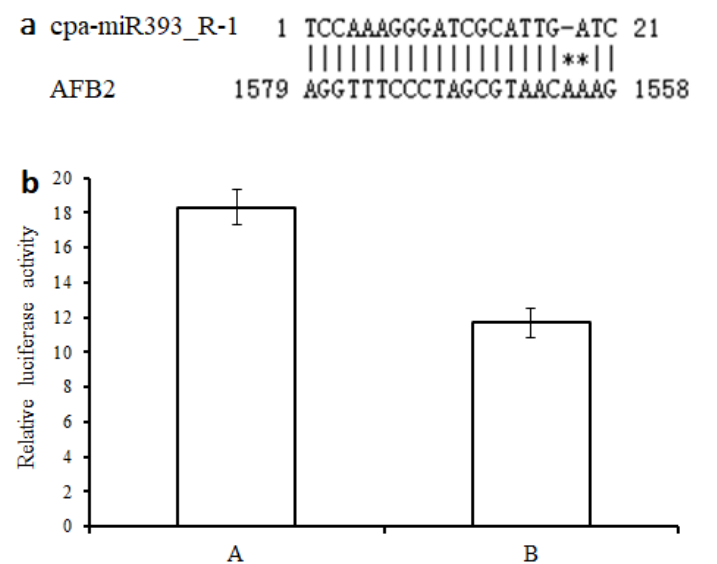
Figure 13. The validation of cpa-miR393_R-1 and target AFB2: ( a ) prediction of the binding sites of cpa-miR393_R-1 in AFB2 mRNA using psRNATarget; ( b ) effect of cpa-miR393_R-1 expression on luciferase activity in transfected cells: (A) pCDNA3.1 + pmirGLO-AFB2, and (B) pCDNA3.1- cpa-miR393_R-1 + pmirGLO-AFB2. Data are represented as the means ± standard deviations (SDs) from three independent experiments.